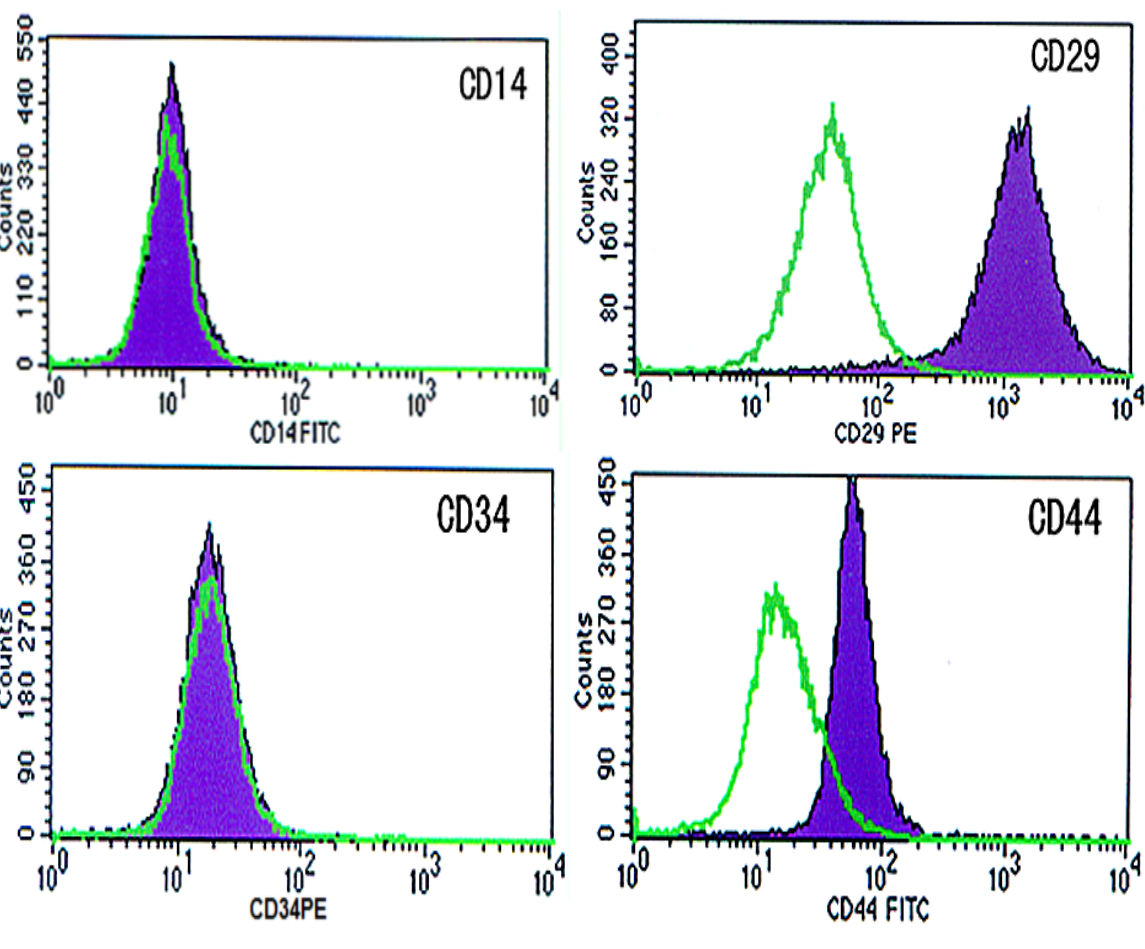
Figure 2. The immunophenotype of